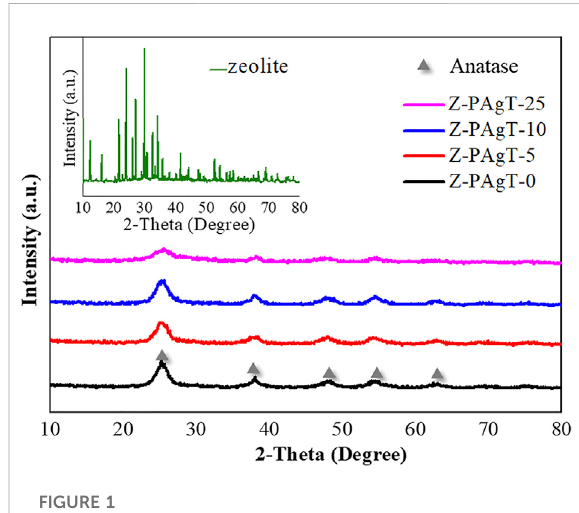
FIGURE 1 XRD patterns of Z-PAgT composite materials with different wt% zeolite addition and pure zeolite